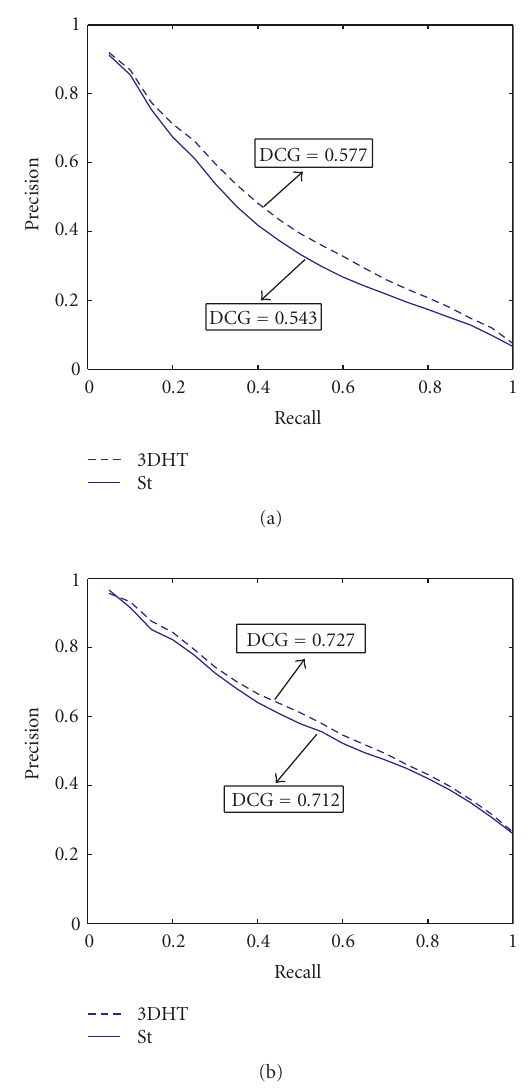
Figure 10: Precision-recall curves for 3DHT and St on PSB test set (a) and SCUdb